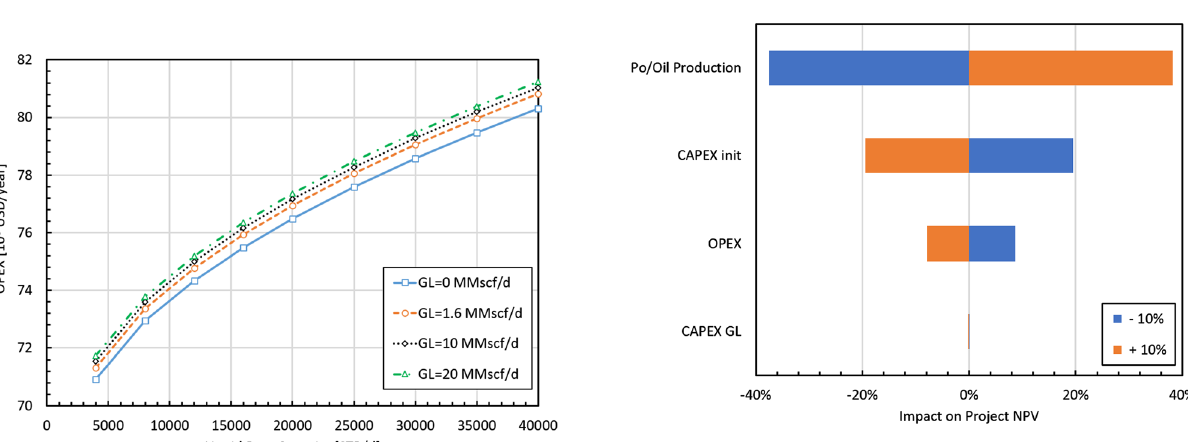
Fig. 14 CAPEX related to the gas lift system installation as a func- tion of gas lift injection capacity